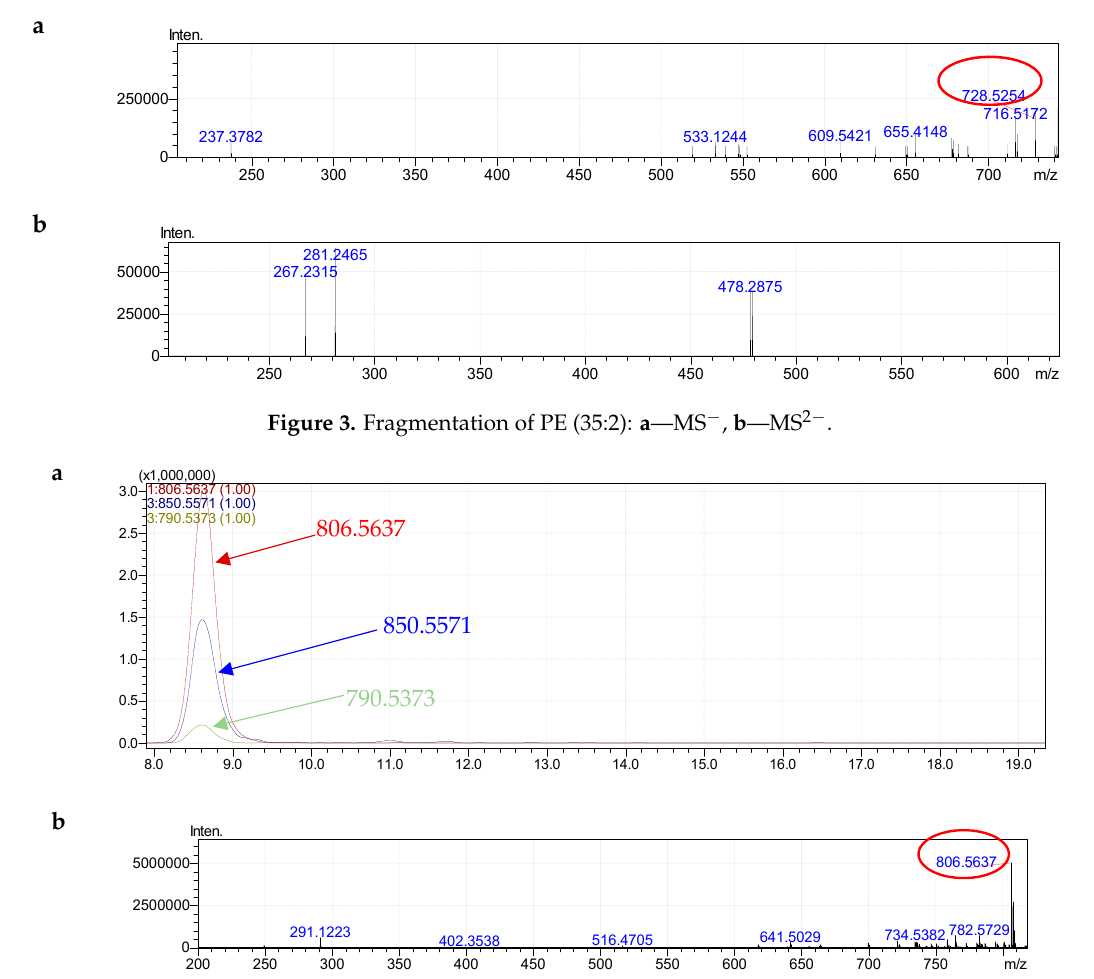
Figure 2. HPLC–HRMS ( a ) and fragmentation of PE 36:1( b —MS + , c —MS − , d —MS 2 − ). From the the MS 2 − spectrum of the ions [M − H] − of PE 36:1, one signal corresponding to one carboxylate anion of 18:1 was detected at m / z 281.2466. For the plasmalogen, the fatty acid (FA) anion ([RCOO] – ) can only be liberated from the sn- 2 position due to the ankenyl linkages at the sn- 1 position [32]. Therefore, three possible molecular species including plasmenyl p18:0/18:1. Component PE 36:1 was identified as alkenyl acyl glycerophosphoethanolamine, p18:0/18:1 PlsEtn (Figure S1). Diacyl glycerophosphoethanolamine only accounted for 19.7% of total PE species. For an unknown PL containing two FAs, MS and MS/MS data also are needed to determine the two individual FAs esterified at the sn -1 and sn -2 positions of the glycerol backbone.